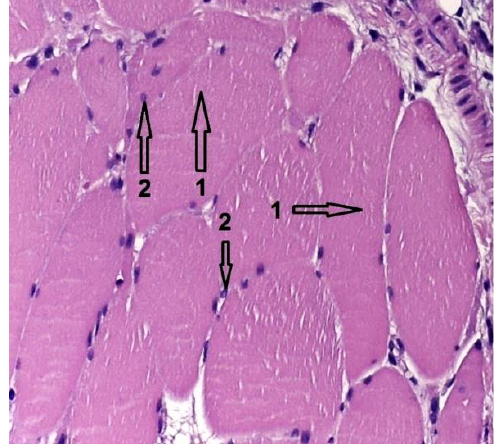
Figure 29. Aspect of muscle tissue harvested remotely from the implant. Hematoxilin–Eosin staining, optical magnification 10 × 20. The appearance is similar to the muscle tissue samples collected from the vicinity of the Mg–1Ca implant. 1-Viable muscle cells, 2-Normal cell nuclei.